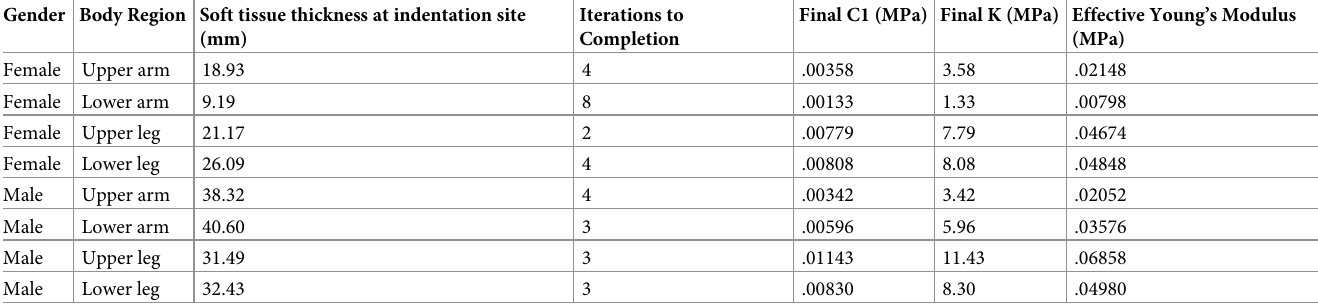
Table 4. Inverse FEA results to calibrate models to capture region-specific surface mechanics